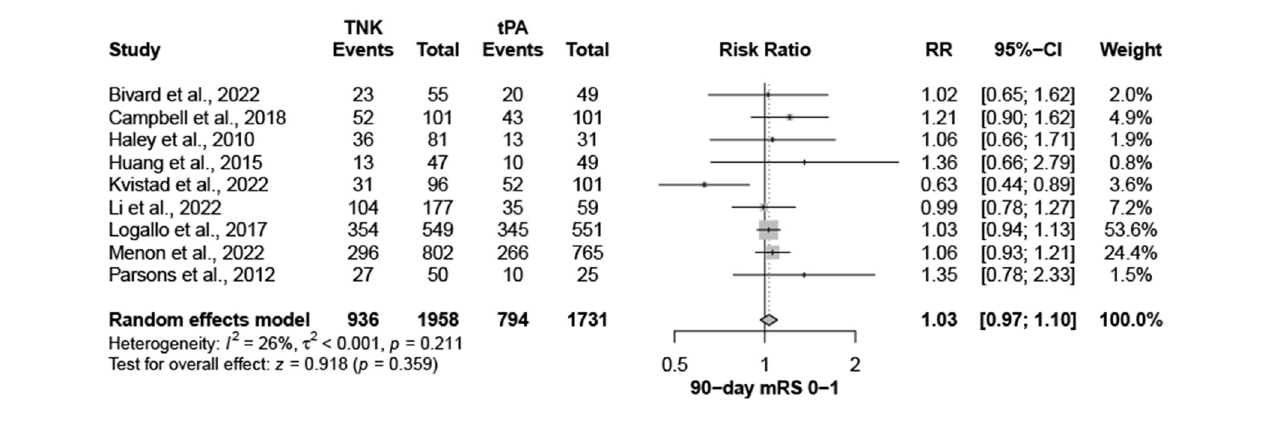
FIGURE1 Rates of mRS 0–1 at 90 days. TNK, tenecteplase; tPA, alteplase.